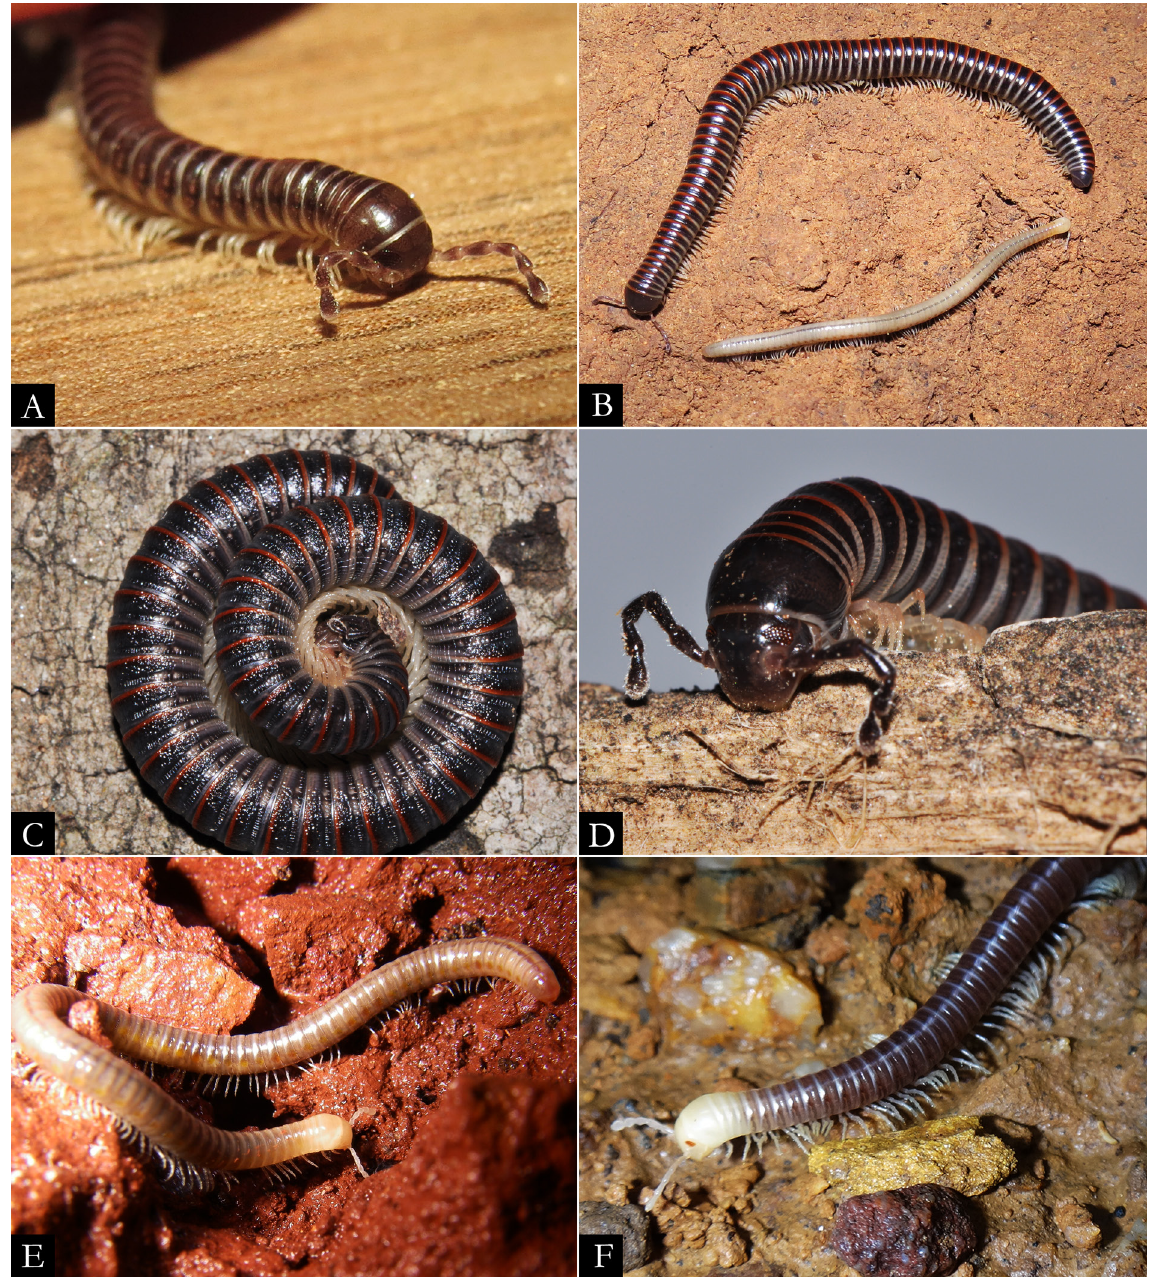
Fig. 18. Living specimens. A . Pseudonannolene urbica Schubart, 1945, from Mogi das Cruzes, SP, Brazil. B . Pseudonannolene spp. (troglophilic and troglomorphic species) from Lassance, MG, Brazil. C–D . P. granulata sp. nov. , from Cambuci, RJ, Brazil. E . P. spelaea Iniesta & Ferreira, 2013, from